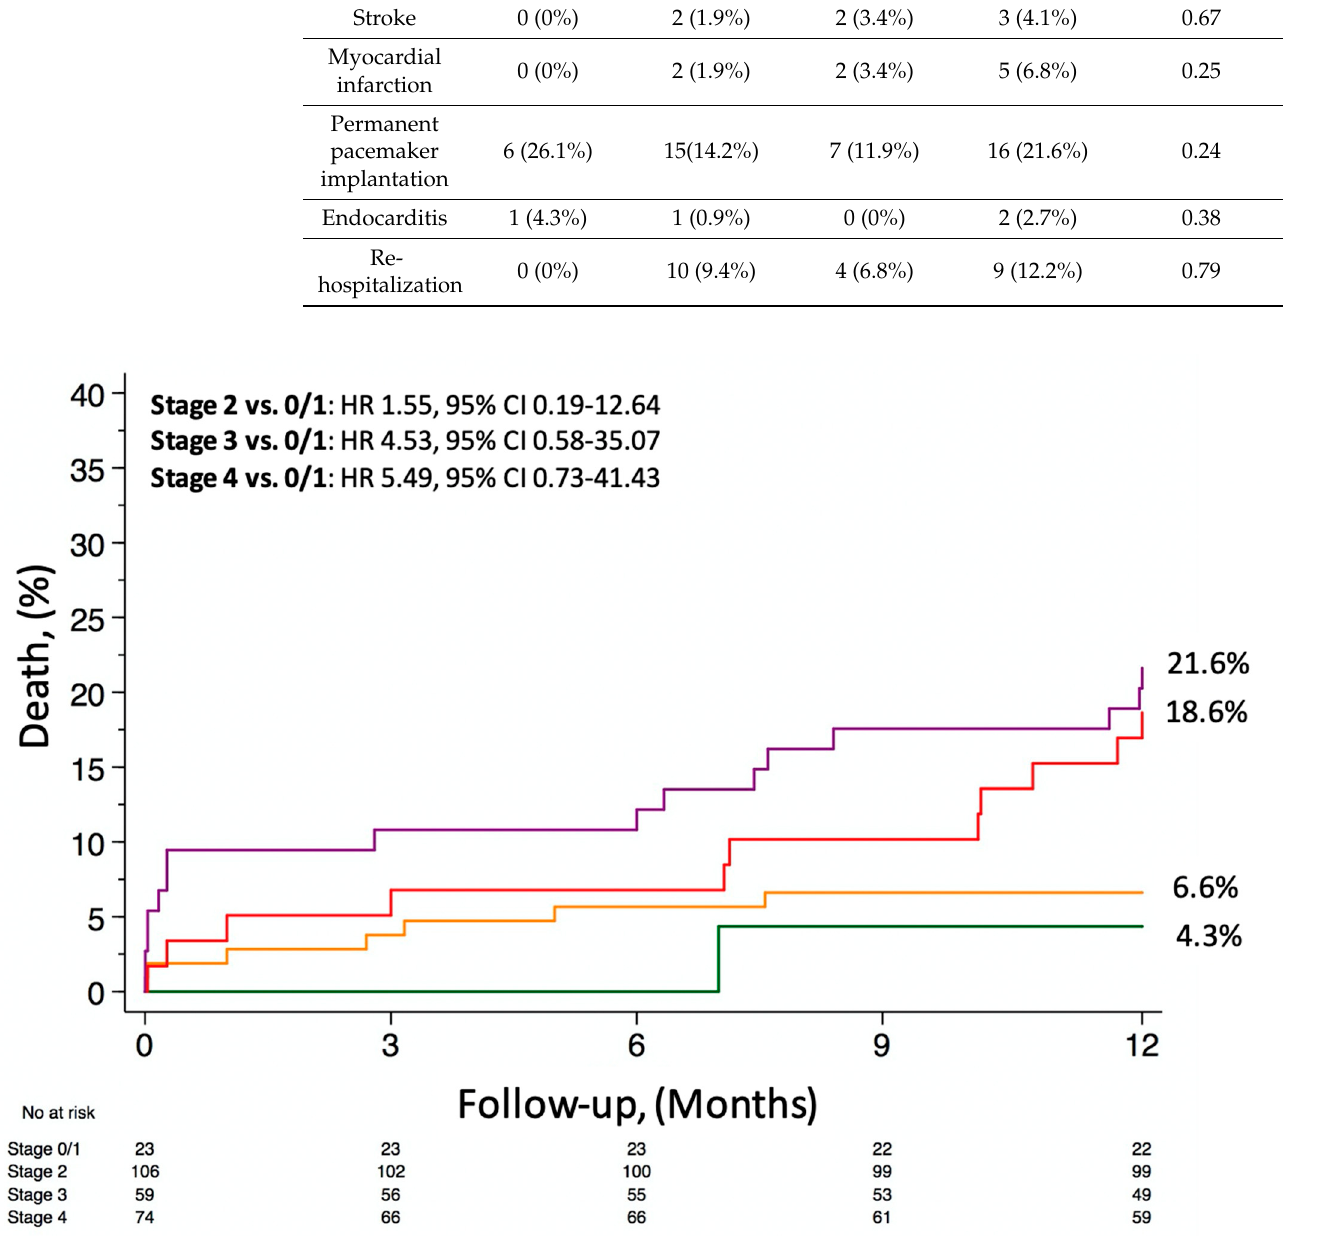
Figure 3. All-cause mortality according to the stage of cardiac